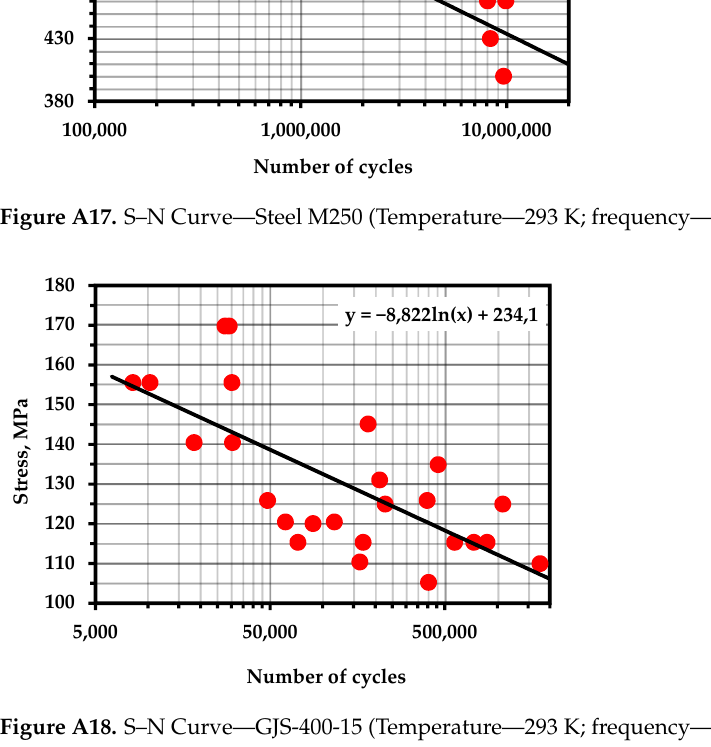
Figure A18. S–N Curve—GJS-400-15 (Temperature—293 K; frequency—20 Hz) [109].